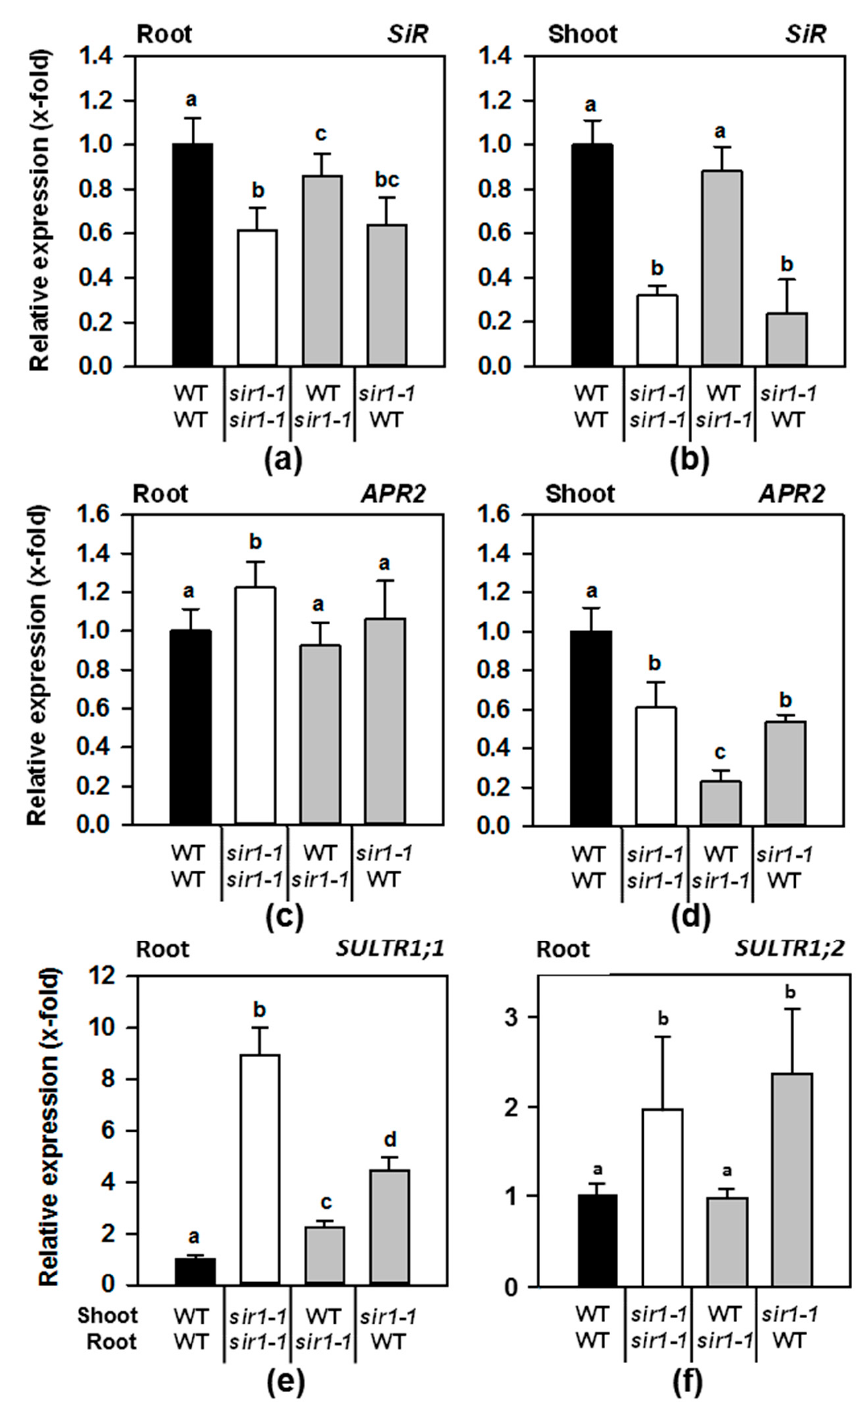
Figure 2. Steady-state transcript levels of key genes in the sulfur-assimilation pathway in micro- grafted plants. Transcript levels were determined by qRT-PCR using TIP41 -like (At4g34270) as the reference gene in the roots ( a , c , e , f ) and shoots ( b , d ) of grafted plants. The level in control roots and shoots was set to 1, and the other values are expressed as x-fold of control. Data are shown as means ± SE ( n = 4). Different letters indicate individual groups identified by multiple pairwise comparisons with a Holm–Sidak, one-way ANOVA ( p , 0.05) followed by the Student–Newman–Keuls posthoc test.